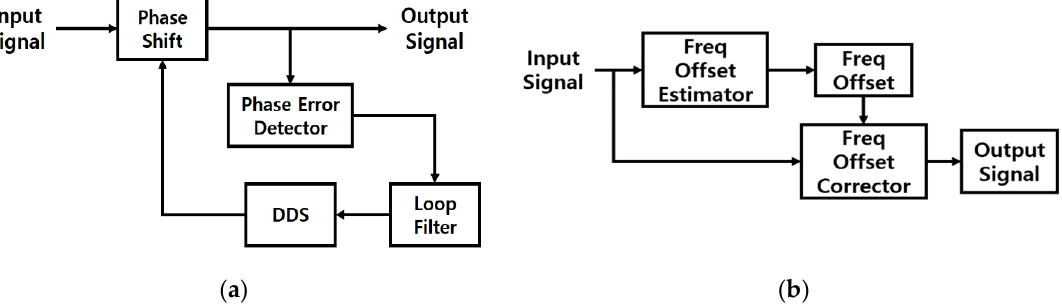
Figure 6. Block diagram of ( a ) carrier synchronizer function and ( b ) frequency offset estimator function.